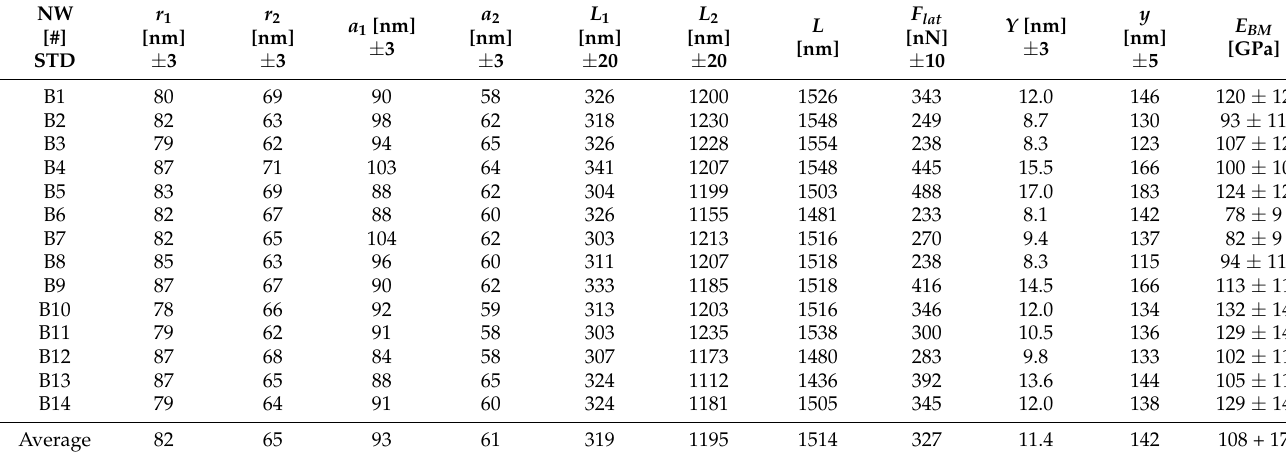
Table 1. Detailed parameters and results of the bending experiment on 14 NWs. The columns from left to the right denote: nanowire number (NW), lower ( r 1 ) and upper ( r 2 ) diameter of the truncated cone, lower ( a 1 ) and upper ( a 2 ) projected width of the truncated hexagonal pyramid, height of the truncated cone ( L 1 ), whole length of the nanowire ( L ), bending load ( F lat ), cantilever deflection ( Y ), nanowire deflection ( y ) and calculated bending modulus ( E BM ) using Equation